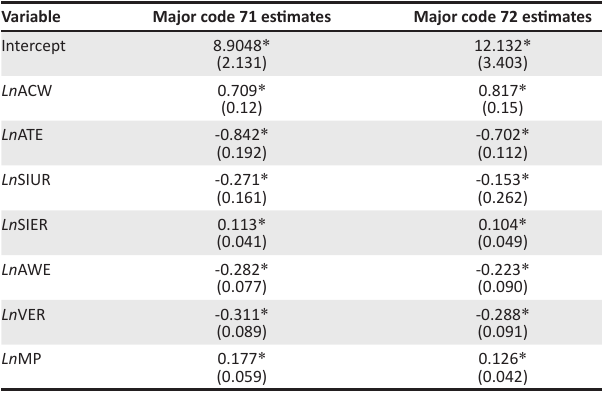
TABLE 4: Estimation results of the fixed-effect panel data estimation. Variable